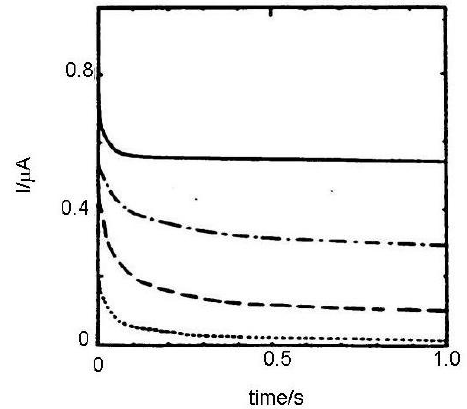
Figure 2. Chronoamperograms of 1 mmol∙dm −3 ferrocene solution in acetonitrile